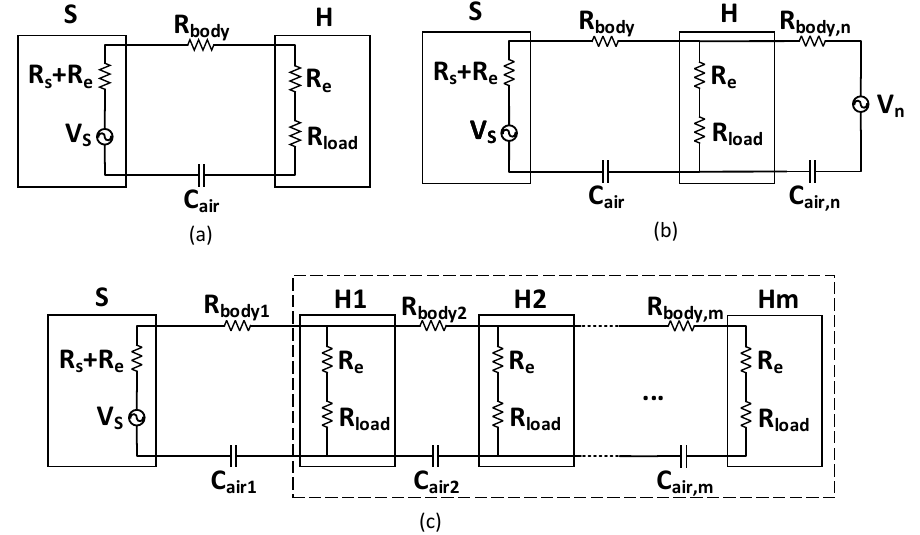
Figure 3. The simplified equivalent circuit model of BC-WPT. ( a ) The single-source single-harvester (SSSH) case. ( b ) The SSSH case with noise. ( c ) The multi-node case where harvesters are on the same side of the